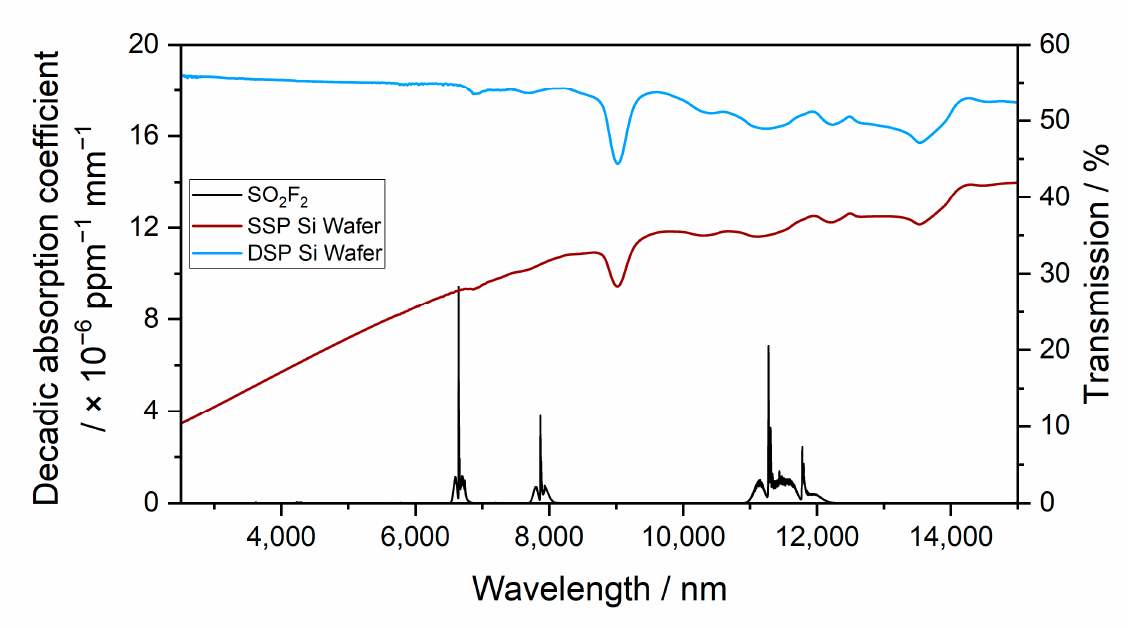
Figure 5. Decadic absorption coefficient spectrum of SO 2 F 2 and the infrared transmission through 500 µm of SSP Si and 500 µm of DSP Si between 2500 and 15,000 nm. Figure 6 shows the emitted spectral power of the infrared source simulated using Equation 1 with an emitter temperature of 650 ◦ C as well as the transmitted spectral power through DSP Si. According to these simulations, the minimum spectral power transmitted into the detector was about 0.006 mW/nm at wavelengths between 7800 and 8100 nm, and it dropped to about one third at wavelengths between 10,500 and 12,200 nm. Nevertheless, the transmitted power was sufficient for the planned application.